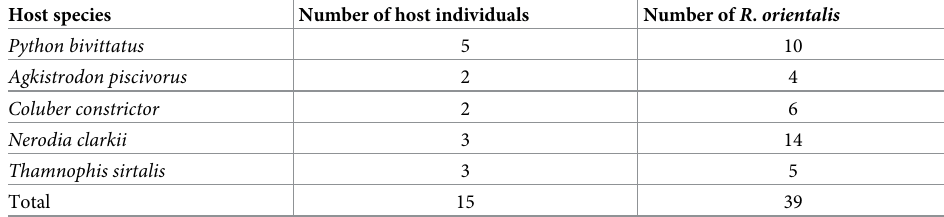
Table 1. Sample sizes of snake hosts and pentastomes ( Raillietiella orientalis ) collected from southern Florida. The number of host individuals and the total number of parasites examined per host are shown for each host species. Snake species native to Florida included Agkistrodon piscivorus , Coluber constrictor , Nerodia clarkii , and Thamnophis sirtalis ; R . orientalis collected from invasive Burmese pythons ( Python bivittatus ) were examined for comparison.